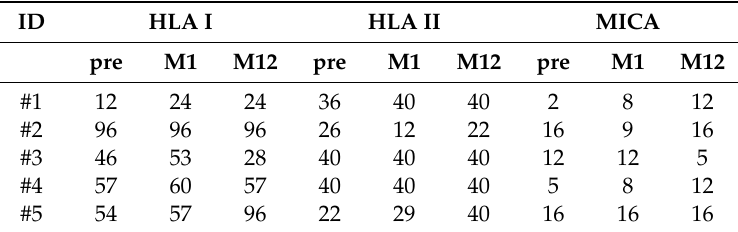
Table 4. Course of HLA / MICA antibodies in five female kidney transplant recipients with antibody- mediated rejection after vaccination with Prevenar.